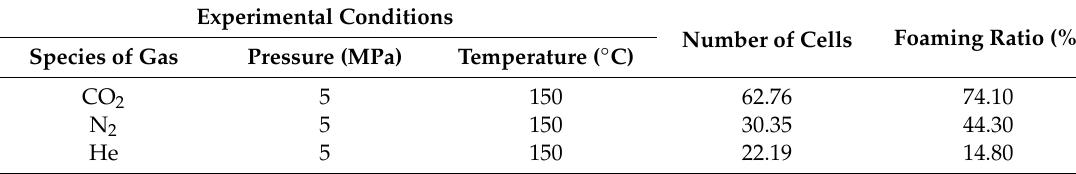
Figure 4. Cross-sectional SEM images of TPU specimens for different gas species.